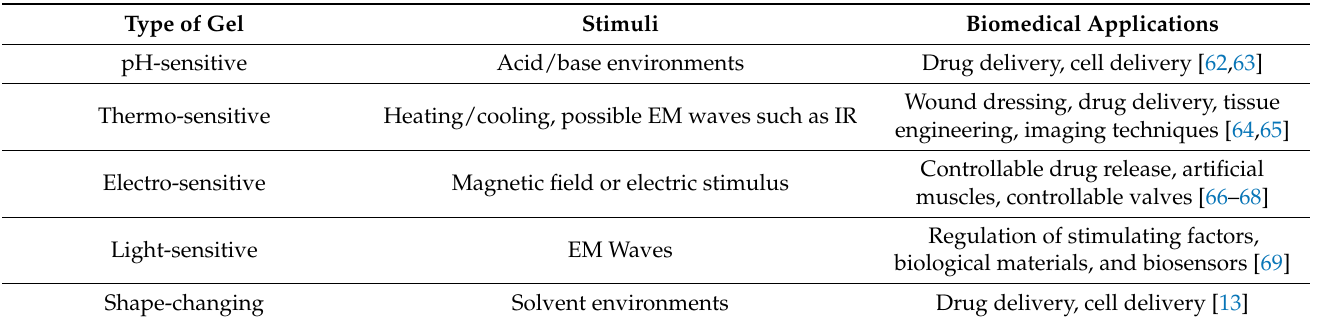
Table 1. Different types of hydrogels based on the stimulus that they respond to, and the potential applications that they have in the biomedical field. Stimuli Biomedical